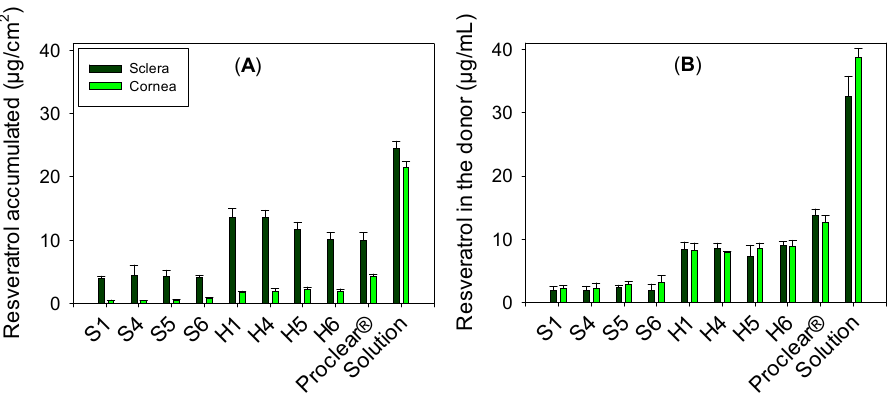
Figure 6. Amounts of resveratrol accumulated in cornea and sclera ( A ) and remaining in the donor chamber ( B ) when delivered as resveratrol-loaded silicone and HEMA hydrogels, and Proclear ® contact lenses, or as resveratrol solution (70 µg/mL).